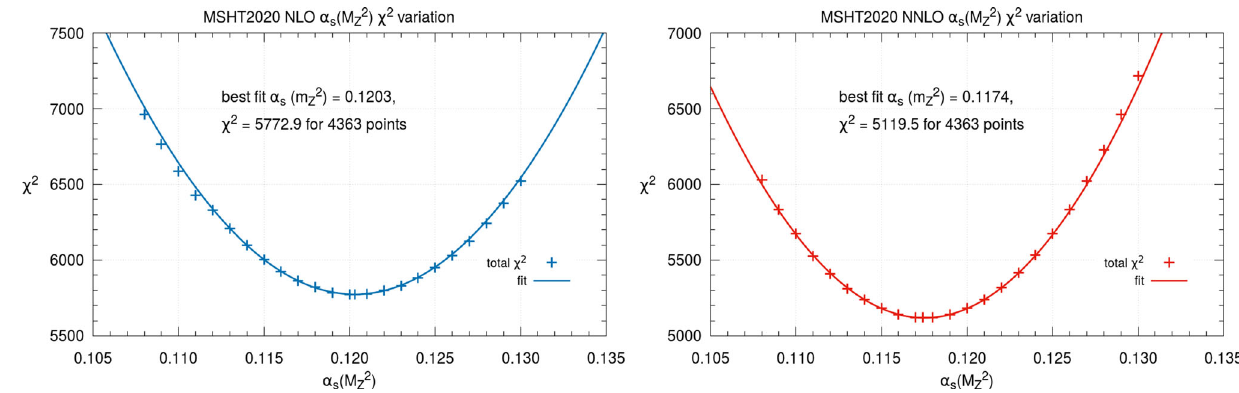
) for the NLO (left) and NNLO (right) MSHT20 Z ) Table1 Thequalityoftheglobalfitversus α S ( M 2 Z